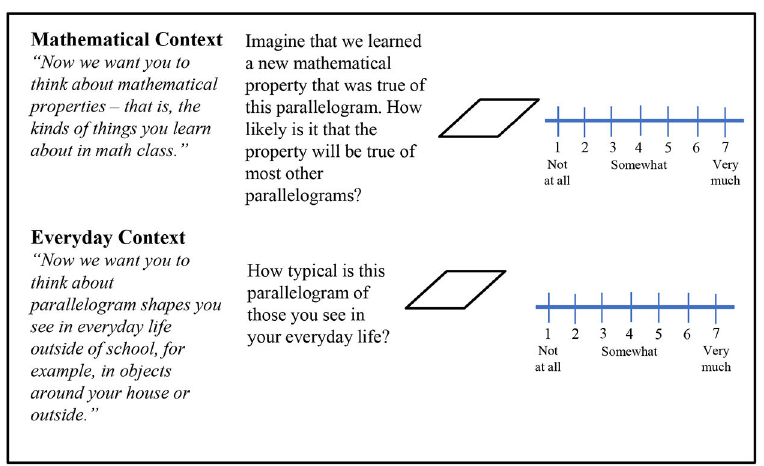
Figure 1. Example of items from survey